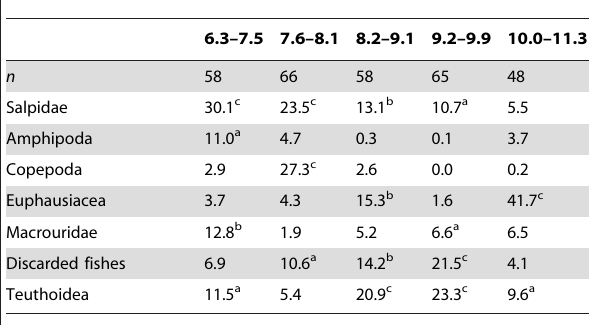
Table 5. Squalus acanthias diet by bottom